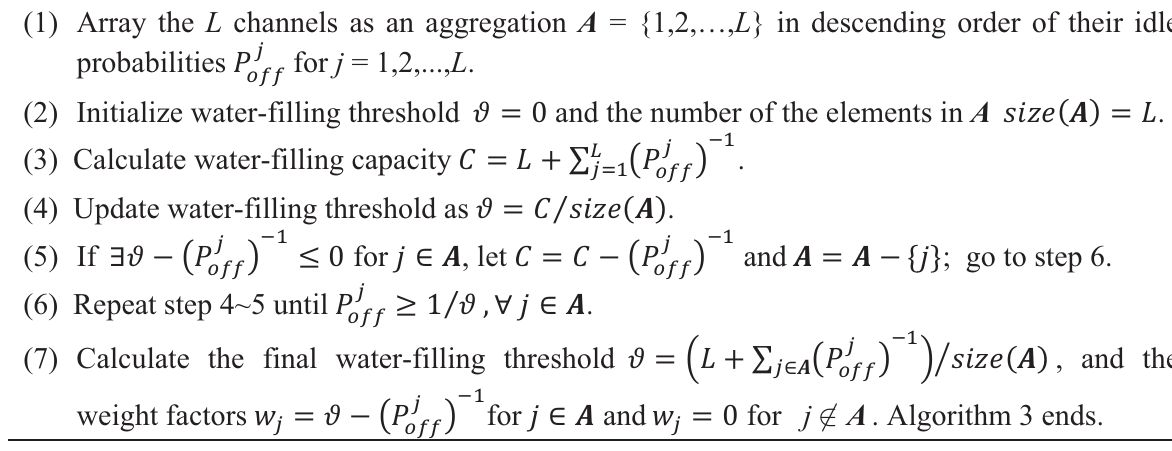
Algorithm 3. Selection of fl based on water-filling principle.